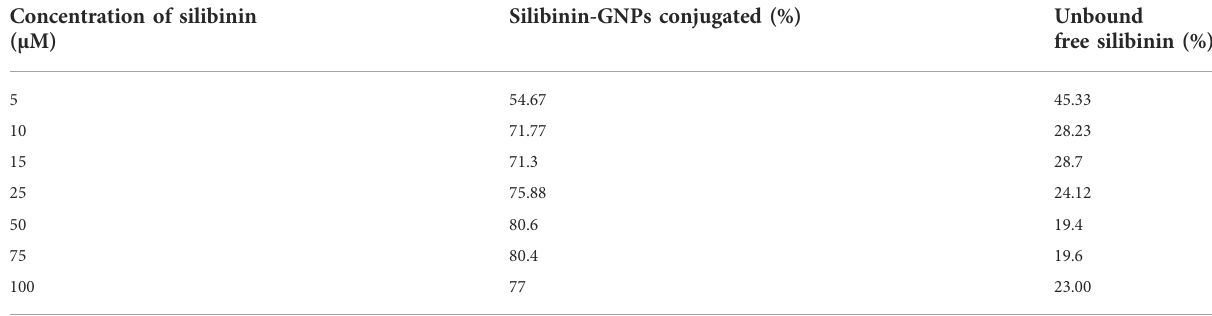
TABLE 1 Table showing the % of conjugated Silibinin to GNPs and % of unbound free Silibinin during conjugation reaction when varying concentrations of silibinin taken for the reaction. The experiments were done in triplicate and results within each pair differed by < 3. Concentration of silibinin Silibinin-GNPs conjugated (µM)